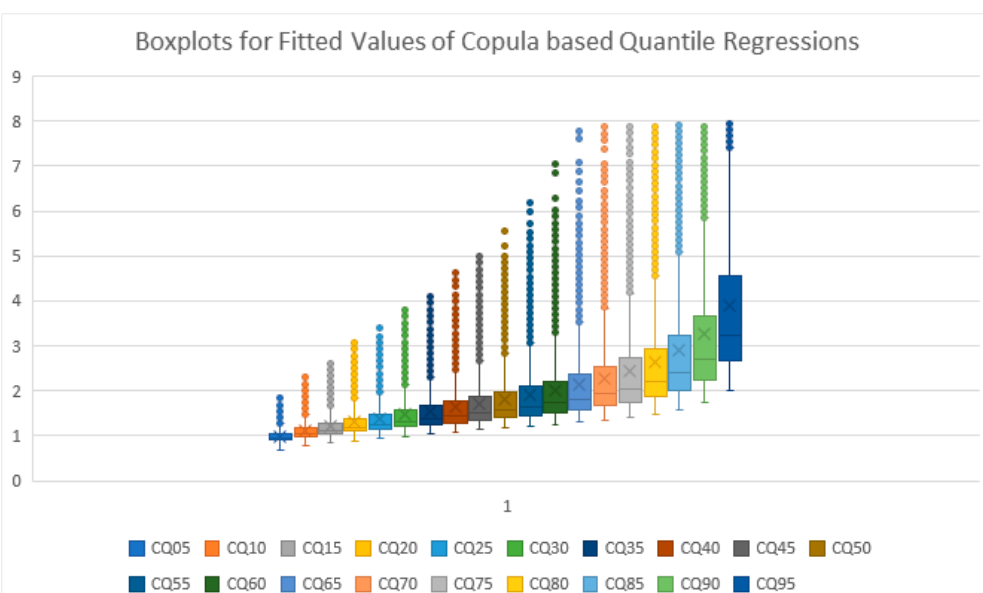
Figure 2. Plots for Fitted values of Quantile Regressions. J. Risk Financial Manag. 2020 , 13 , x FOR PEER REVIEW